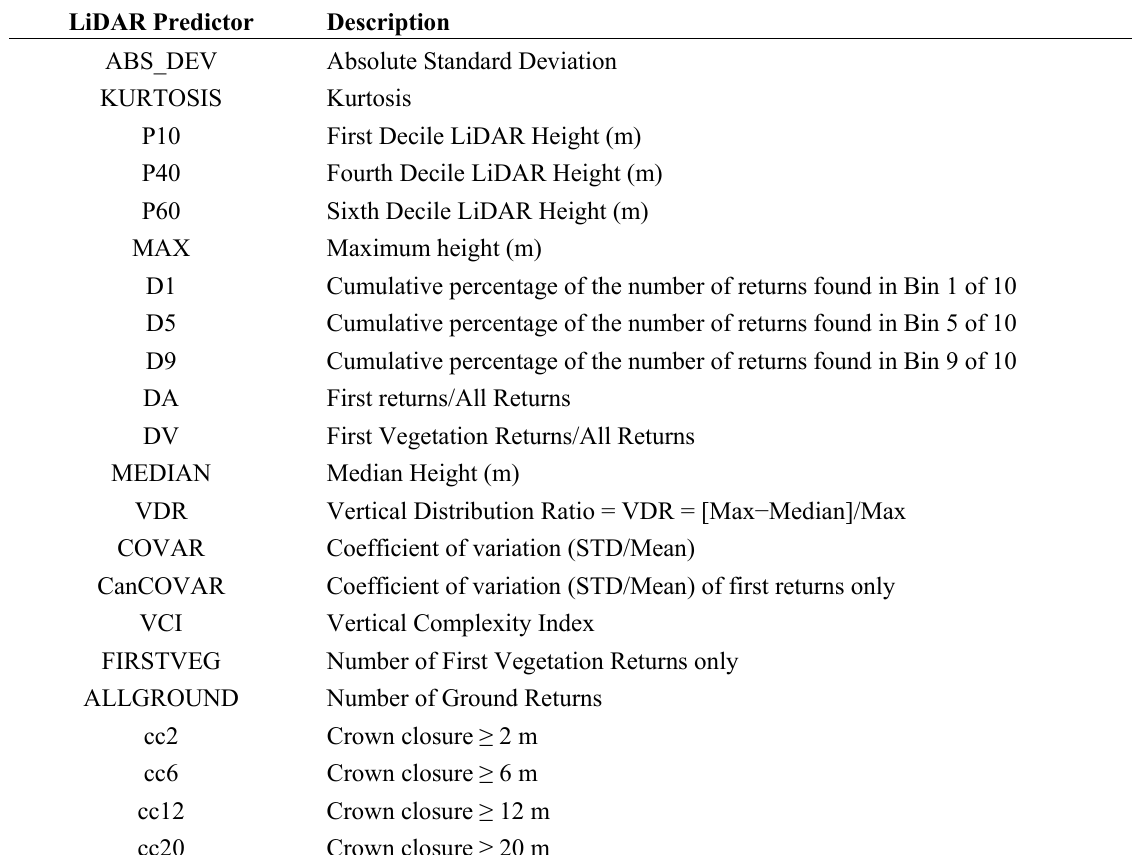
Table 5. Final suite of LiDAR predictor